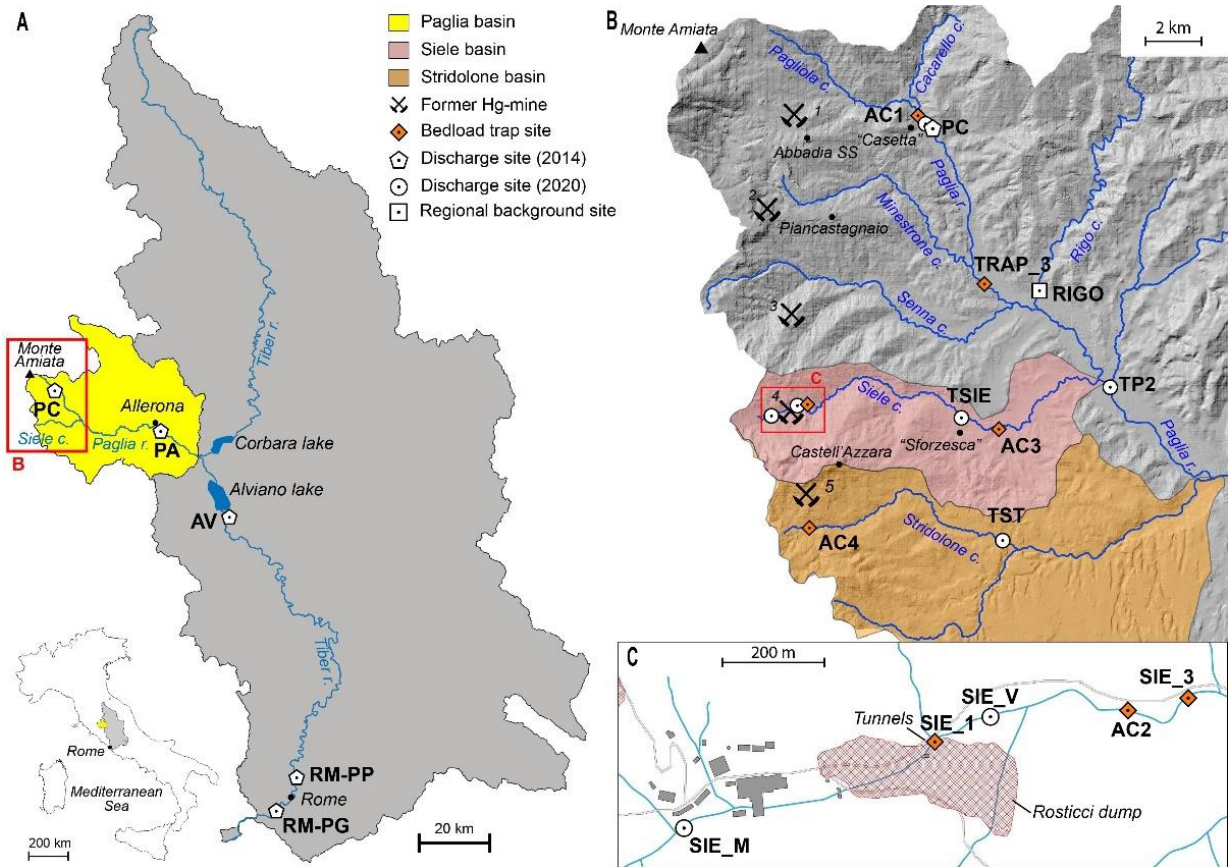
Figure 1. Map of the study area and location of the sampling sites. ( A ) Paglia – Tiber River basin; ( B ) upper part of the Paglia River basin, the Siele (pink area), and Stridolone (orange area) Creek basins; ( C ) details of the Siele mining area. The main mining sites are also reported: (1) Abbadia San Salvatore (ASSM), (2) Case di Paolo, (3) Senna, (4) Siele, (5) Cornacchino.